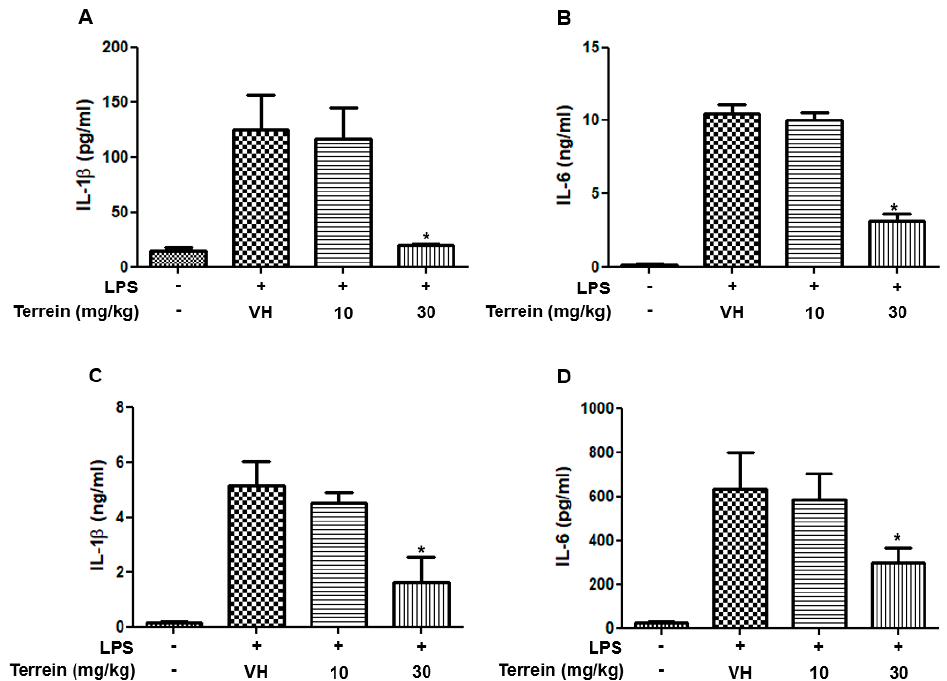
Figure 3. Effect of terrein on the production of inflammatory cytokines in LPS − treated mice. Different groups ( n = 10) of animals were treated with vehicle or indicated concentrations of terrein 2 h before LPS (50 mg/kg) treatment. After 2h, mice were sacrificed and the serum levels of IL − 1 β ( A ), IL − 6 ( B ), the lung tissue levels of IL − 1 β ( C ), and IL − 6 ( D ) were measured using ELISA. Each column shows the mean ± standard deviation of 10 mice. Significance was determined using Dunnett’s t − test versus the vehicle − treated group (* p < 0.05).